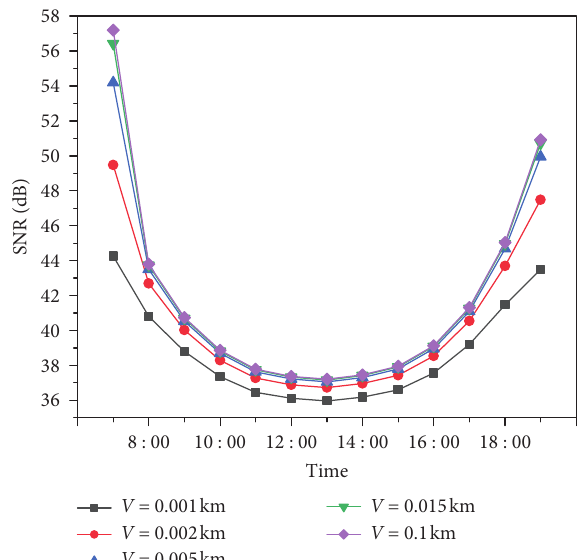
Figure 4: SNR for a day in fire smoke environment with different